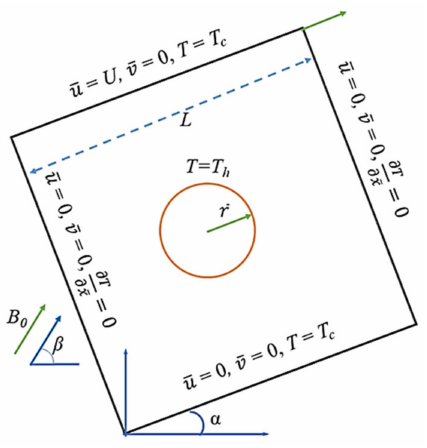
Figure 1. Schematic diagram and the physical